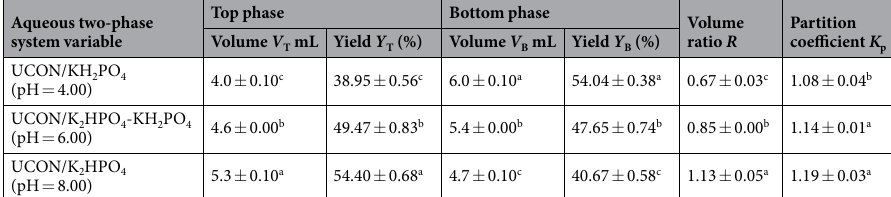
Table 1. Effect of pH on the separation of peptides. 1 The data (mean ± standard deviation) derived from 3 replicates as described in the Materials and Methods section. 2 The difference between the mean values with the same superscript letter in the same column was significant at a 95% confidence interval.